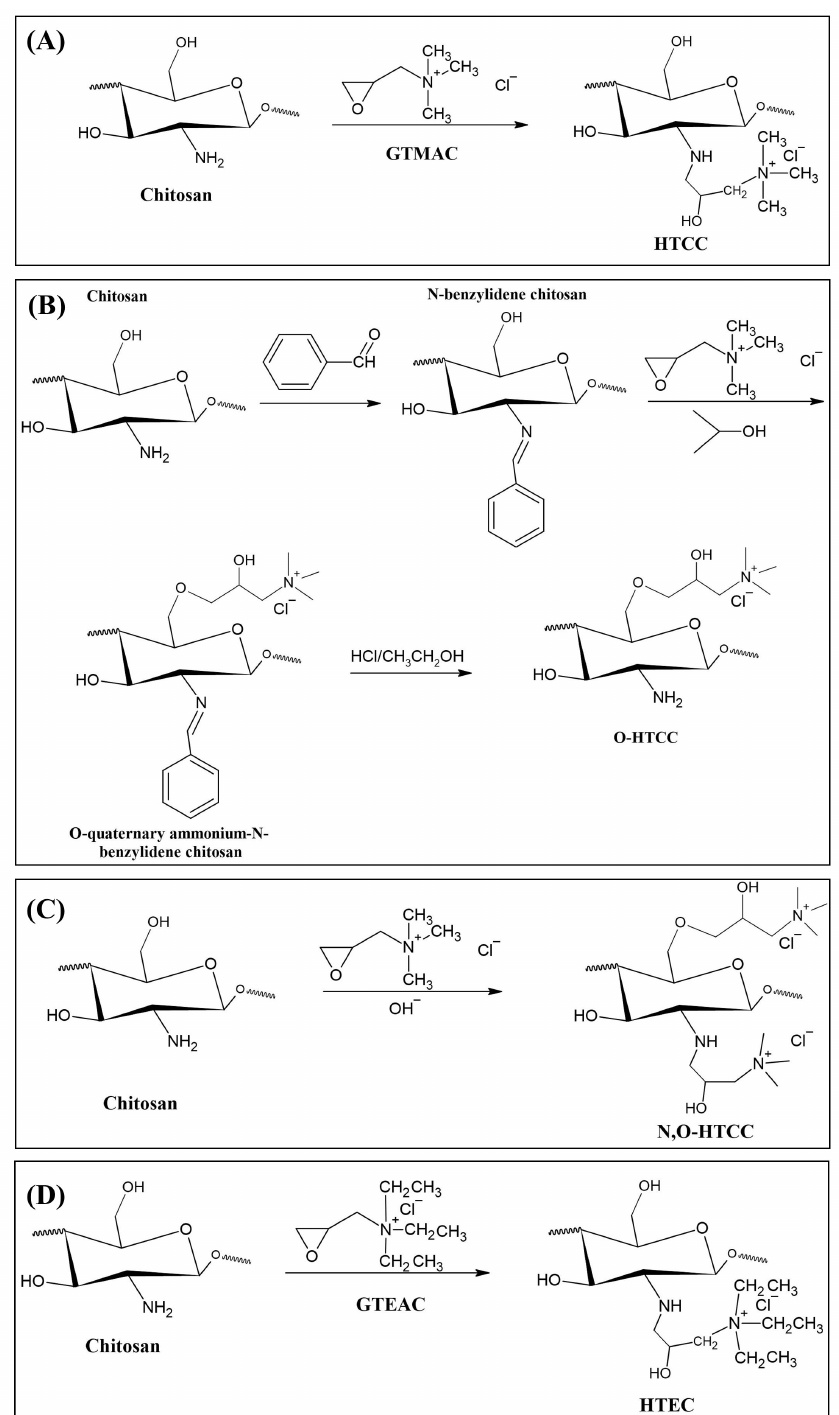
Figure 4. Reaction route for the synthesis of ( A ) HTCC; ( B ) O-HTCC; ( C ) N,O-HTCC and ( D ) N-(2-hydroxyl) propyl-3-triethyl ammonium chitosan chloride (HTEC), from